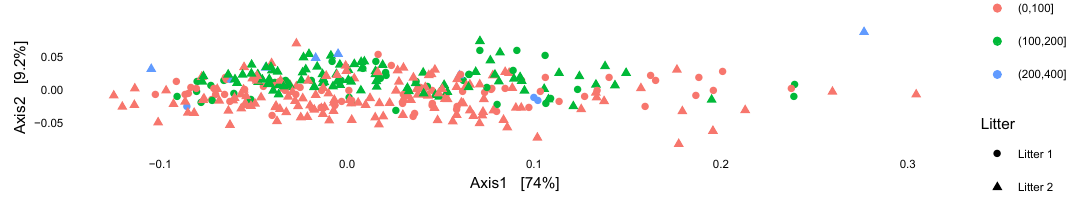
Figure 11. A DPCoA plot incorporates phylogenetic information, but is dominated by the first axis.